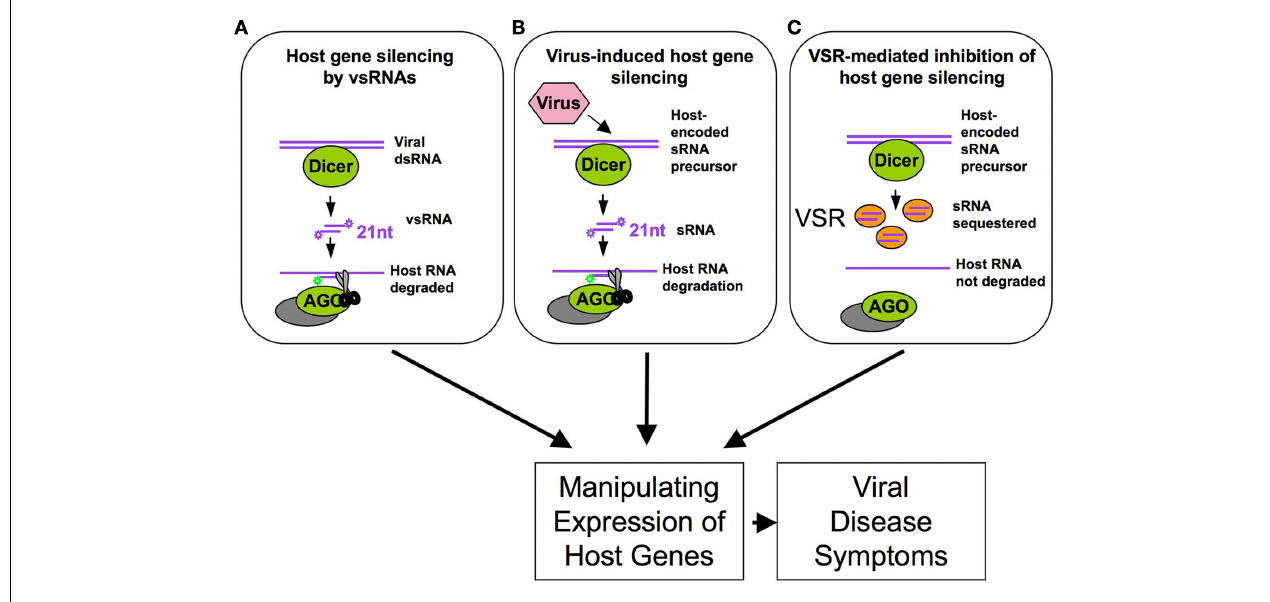
FIGURE 2 |Viral manipulation of host RNA silencing leads to changes in host gene expression and disease symptoms by (A) inducing functional virus-derived vsRNAs complementary to host genes and by (B) inducing or (C) suppressing the production of functional host sRNAs (e.g., here: sequestration of host